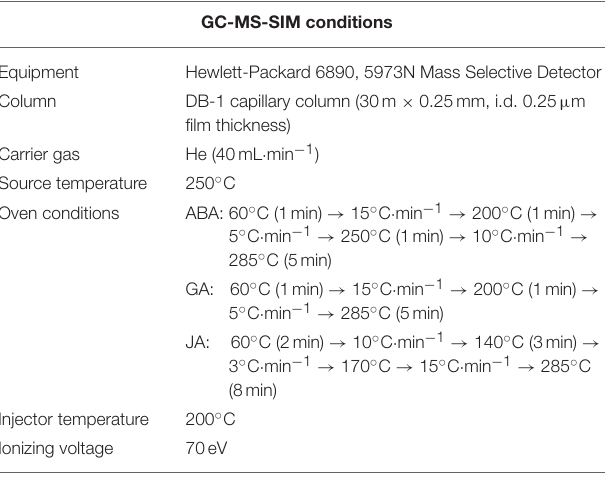
TABLE 2 | GC-MS-SIM conditions for the determination of endogenous ABA, GA, and JA.